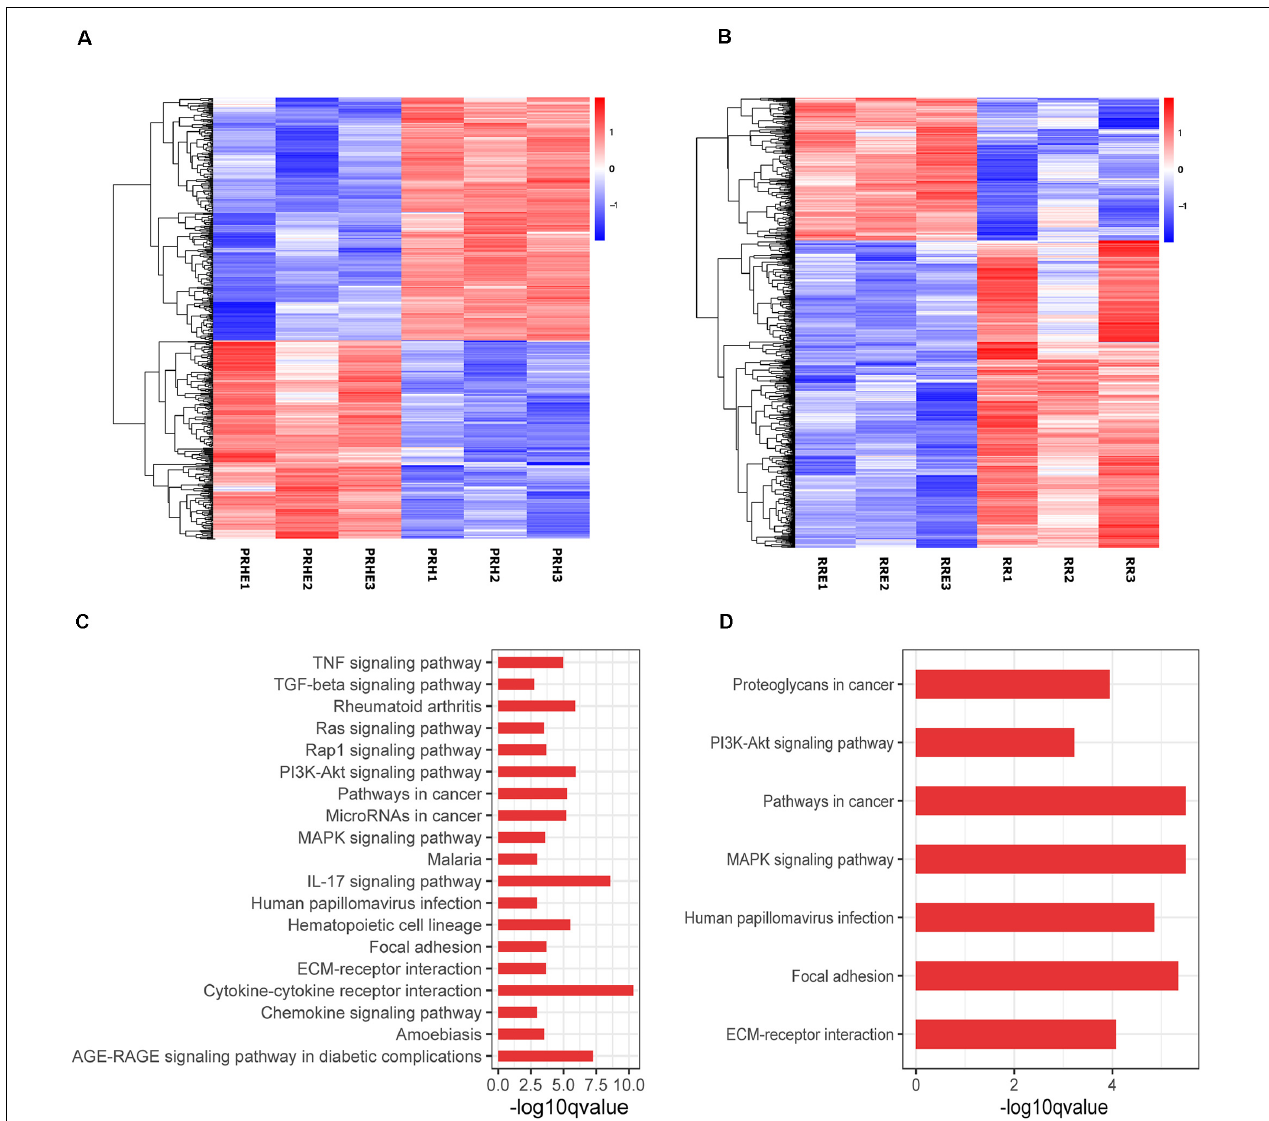
FIGURE 8 | Results of RNA-seq in ESCs-cocultured premature and replicative senescent RPE cells. (A) The heat map of all differentially expressed genes for the PRH and PRHE groups ( n = 3 biological repeats). (B) The heat map of all differentially expressed genes for the RR and RRE groups ( n = 3 biological repeats). The horizontal axis represents three biological repeats of the samples, and the vertical axis represents the genes. The red color indicates upregulated expression and the blue color indicates downregulated expression. (C) The bar diagram of Kyoto Encyclopedia of Genes and Genomes (KEGG) pathway analysis of the PRH and PPHE groups ( n = 3 biological repeats). (D) The bar diagram of KEGG pathway analysis of the RR and RRE groups ( n = 3 biological repeats). The abscissa represents the enrichment degree. The greater –log10 q value indicates the higher enrichment degree of KEGG pathway. The ordinate represents the name of the KEGG pathway.